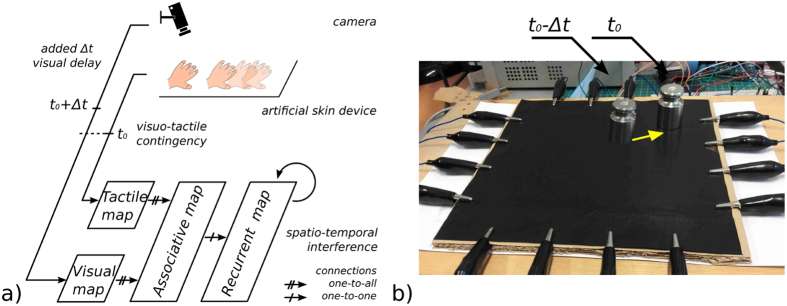
Experimental setup for modeling illusory effects in a visuo-tactile neural architecture of the parietal cortex using a tactile device and delayed visual feedback.In (a), the artificial neural networks receive the unimodal visual and tactile sensory inputs as incoming information. The first layer performs an initial pre-filtering, and the second layer consists of an associative map that binds the two unimodal neural populations. Finally, the third layer corresponds to a recurrent map that integrates over time the instantaneous visuo-tactile signals. This last network has the capabilities of a working memory to resist noise and temporal delays, as it governs the internal representation of the parietal cortex. In (b), visual temporal delays on the camera are equivalent to the spatial tactile displacement on the artificial skin.